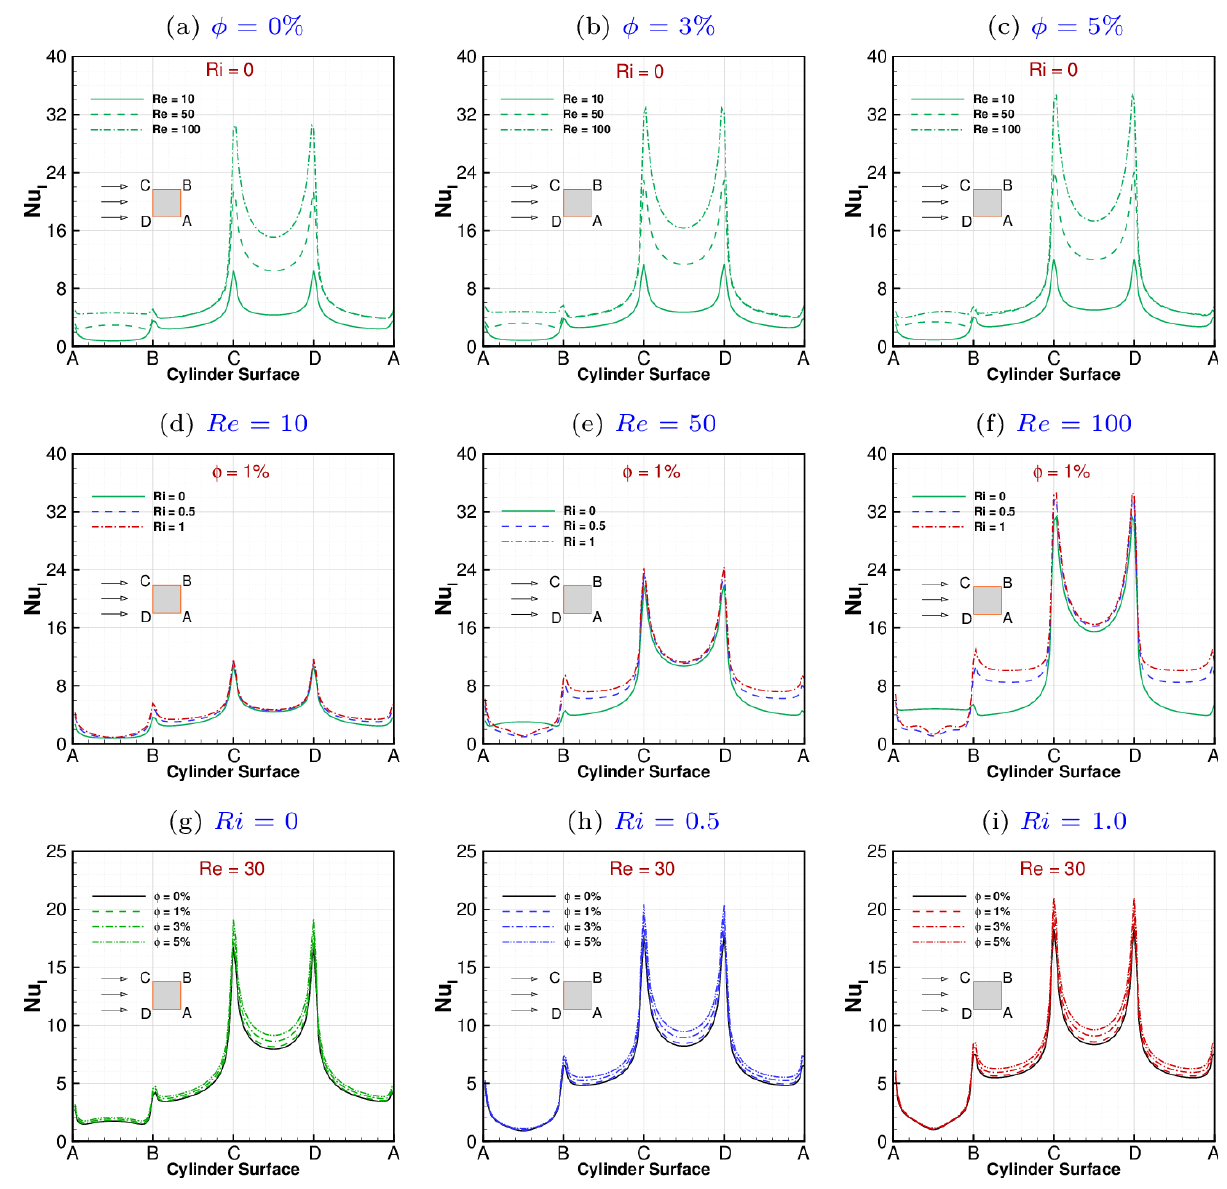
Figure 13. Local Nusselt number ( Nu l ) distributions on the surface of a heated square cylinder at the considered parameters: ( a ) φ = 0%, ( b ) φ = 3%, ( c ) φ = 5%, ( d ) Re = 10, ( e ) Re = 50, ( f ) Re = 100, ( g ) Ri = 0, ( h ) Ri = 0.5 and ( i ) Ri = 1.